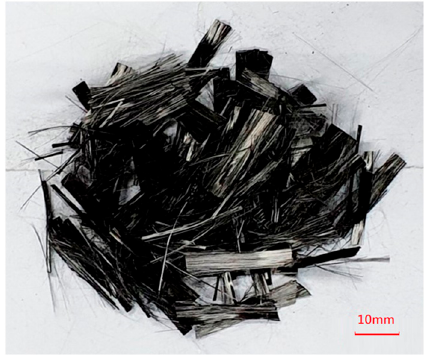
Figure 1. Chopped carbon fiber (24 mm).